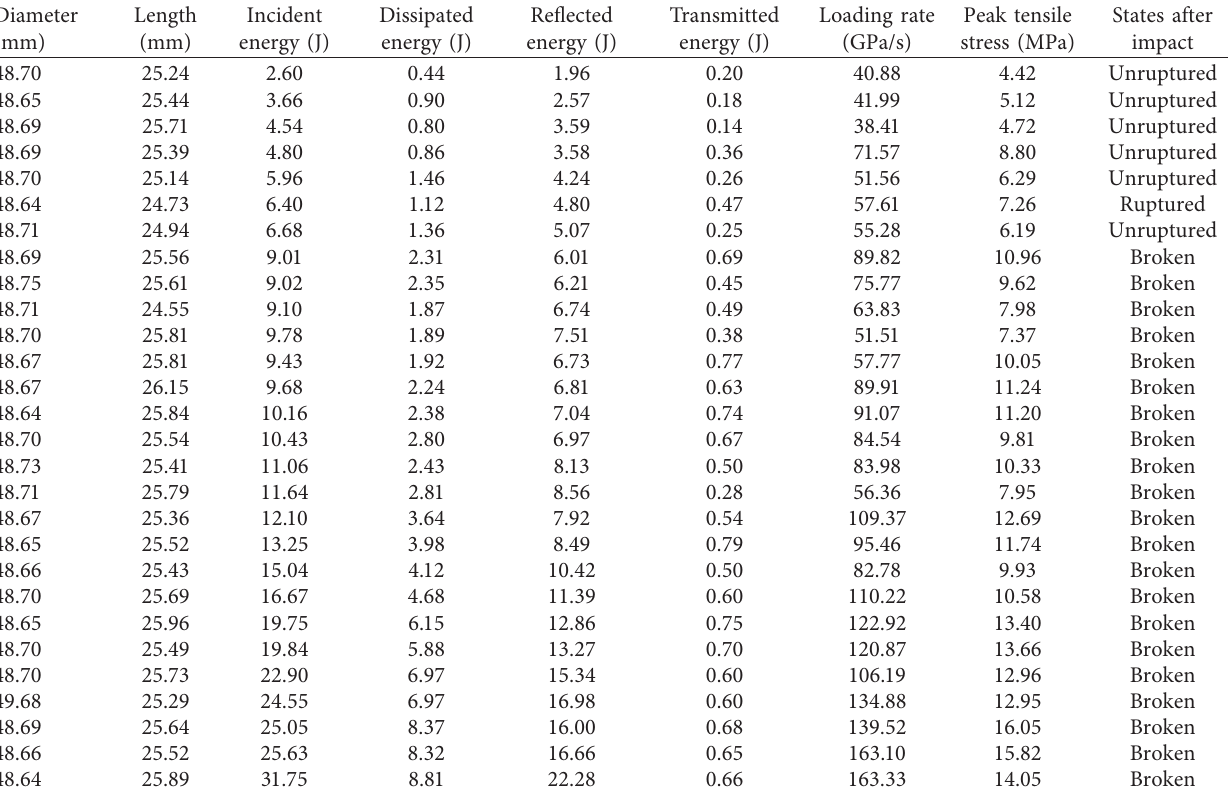
Figure 2: Stress equilibrium check for the dynamic Brazilian disc testing of a red sandstone specimen (‘Inc’ is the incident stress, ‘Re’ is the reflected stress, ‘Tra’ is the transmitted stress, and ‘Inc+Re’ is the superimposed stress at the end of the incident bar). Table 1: Energy and mechanical data of red sandstone